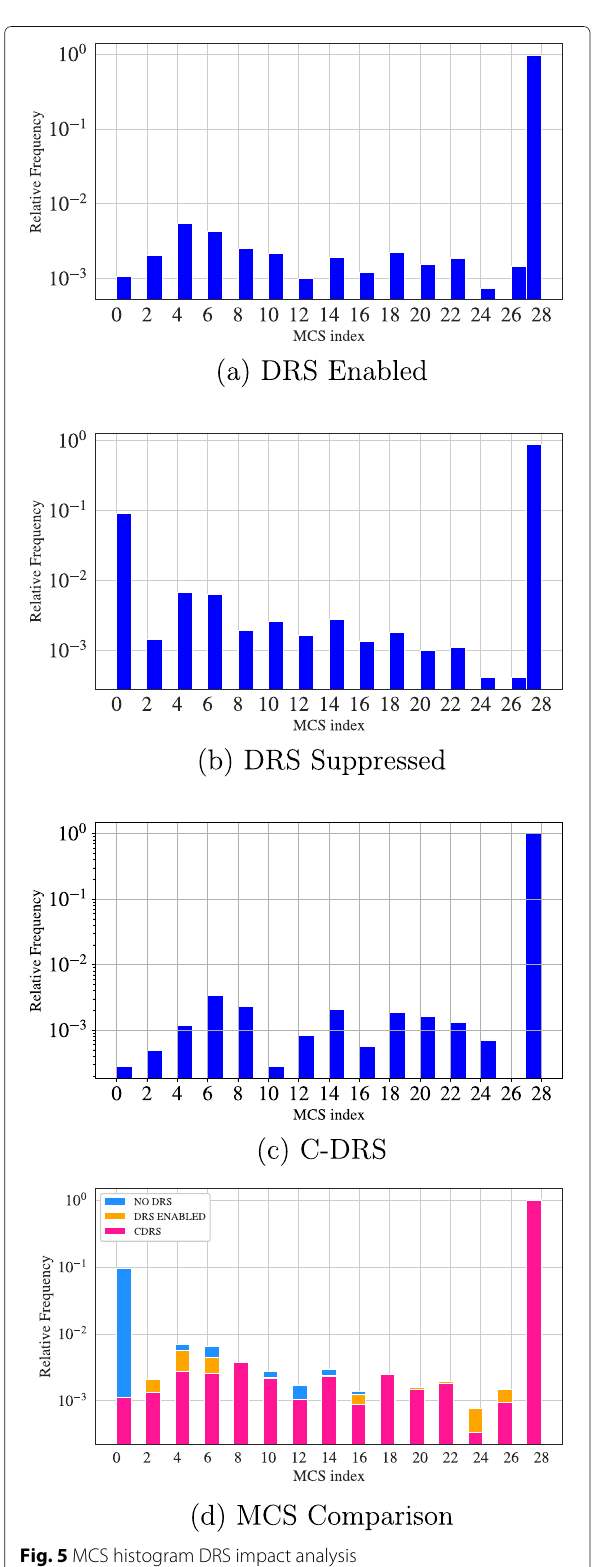
Fig. 5 MCS histogram DRS impact